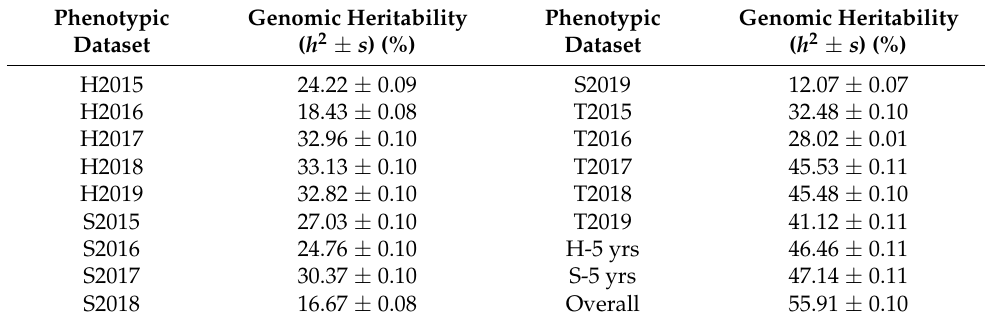
Table 2. Genomic heritability ( h 2 ± s ) of the marsh spot resistance index (MSRI) of 138 recombinant inbred lines (RILs) from the Cran09/Messina